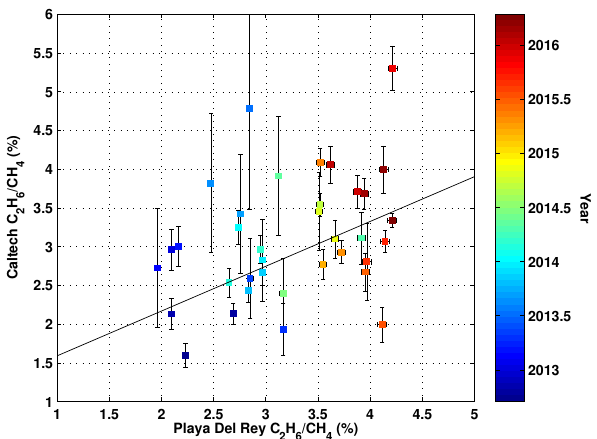
Figure 8. This figure shows the ethane to methane ratios from the Caltech FTS data on the y axis and from the Playa Del Rey gas stor- age facility on the x axis between September 2012 and March 2016. The colours indicate the date of the measurements. The slope of the relationship is indicated by the black line (0 . 58 ± 0 . 12) and is con- sistent with the slope derived from Fig. 7.